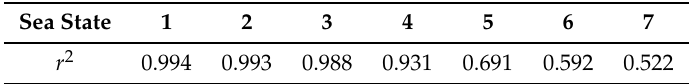
Table 4. Repeatability of waves and current. Mean coefficient of determination, r 2 , shown for each test. Averaged over all repeats compared to all other repeats and over all gauges. Sea state references correspond to those defined in Table 3.